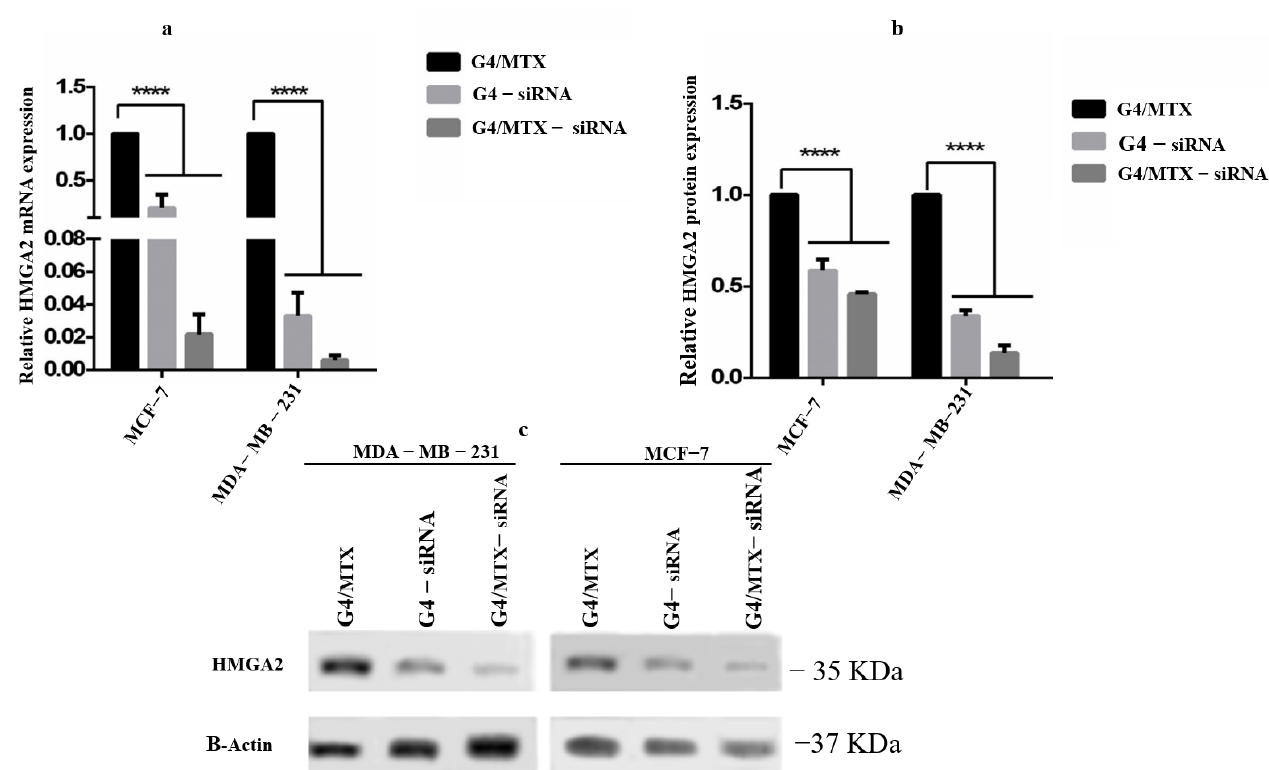
Figure 4. In vitro HMGA2 gene silencing and protein suppression in FR expressing cancer cells. MCF-7 and MDA-MB-231 cells were transfected with G4-siRNA and G4/MTX-siRNA for 48 h. Relative HMGA2 mRNA ( a ) and protein expression ( b ) were analyzed via Real time-PCR and western bolting respectively. ( c ) qualitative band of HMGA2 and β -actin proteins after siRNA was transfected. The results were expressed as mean ± SD ( n = 3); **** p value < 0.0001 vs. G4/MTX nanosystem as control).